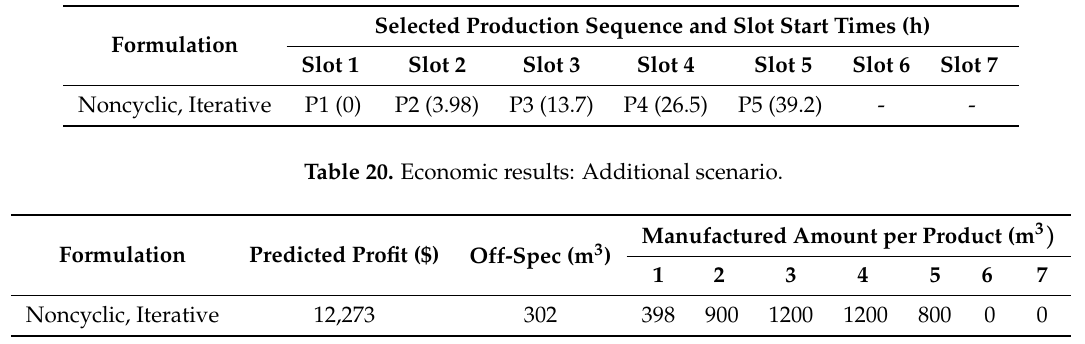
Table 19. Production schedule: Additional scenario.